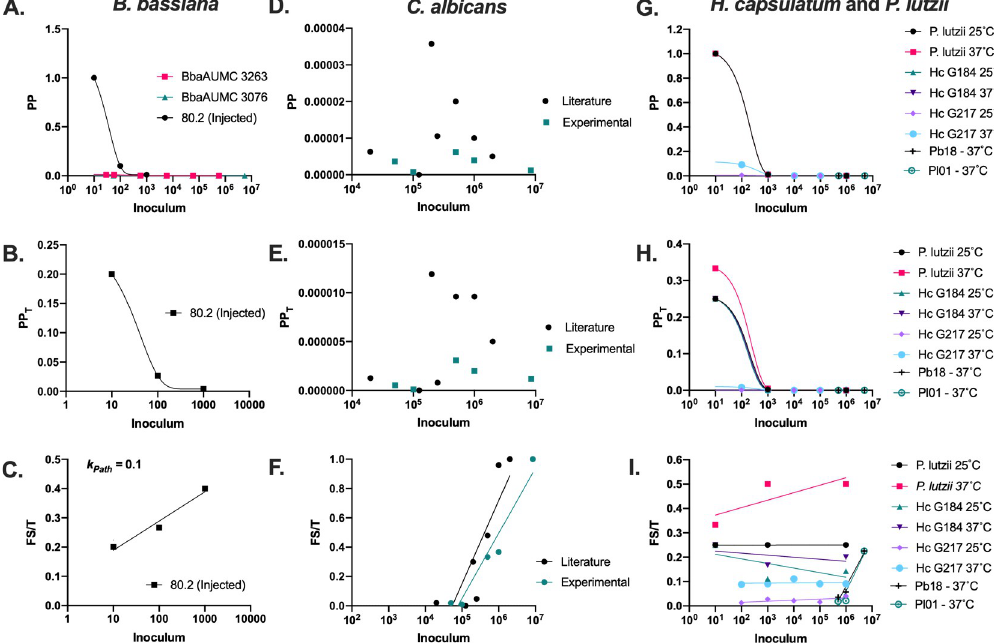
Fig 5. Pathogenic potentials of other fungi in G. mellonella hosts . Using existing published values [5–10] , we calculated (A) PP, (B) PP T , and (C) Fs/T for the entomopathogenic fungus Beauveria bassiana’s . These showed similar relationship to inoculum as C . neoformans . Similarly, we calculated C . albicans’ (D) PP, (E) PP T , (F) and Fs/T and plotted it versus inoculum from previously published and new experimental data. We did not see a clear association of PP and PP T with the inoculum, however, there was a logarithmic relationship between the inoculum and Fs/T (F). For Histoplasma capsulatum , Paracoccidioides lutzii , and Paracoccidioides brasiliensis , we used literature sources to calculate the (G) PP, (H) PP T , and (I) Fs/ T vs. inoculum with different strains and temperatures and found that the PP and PP T mostly had a relationship with inoculum that was best fitted by a one phase exponential decay line. The Fs/T values were mostly independent of inoculum used, with the exception of the Pb18 and Pl01 strains at higher inoculums. (A,D,E) PP vs I and (B,E,H) PP T vs I data was fitted by a one phase exponential decay function, and (C,F,I) Fs/T vs data was fitted by a semi-log line in which the x-axis is logarithmic.